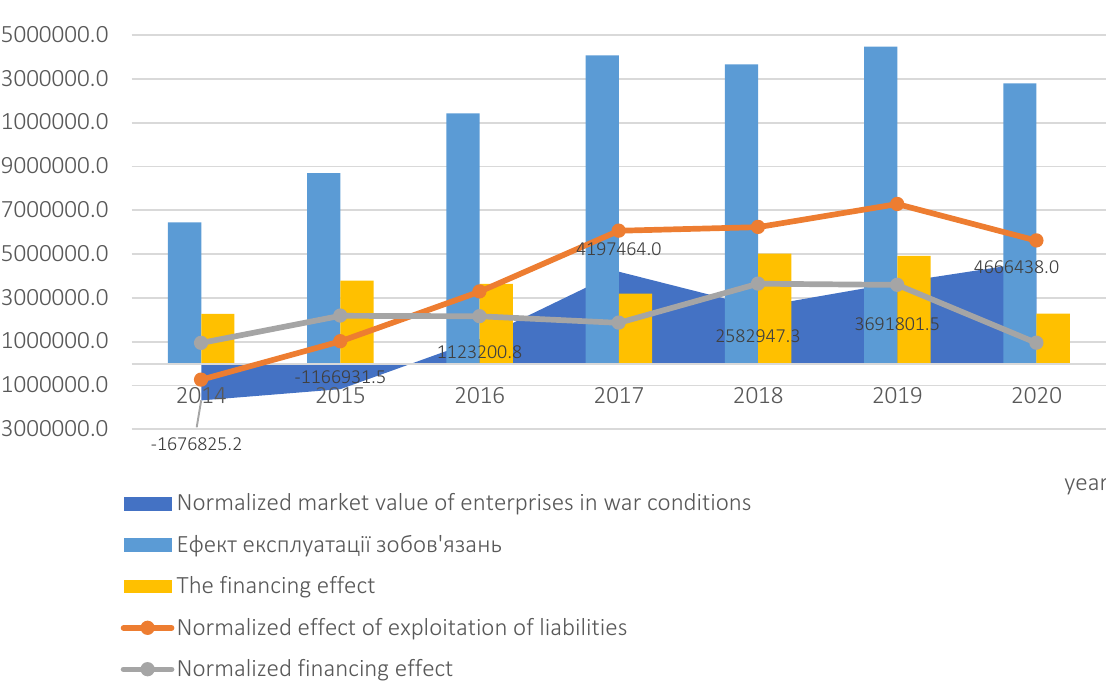
Figure 4. Actual and normalized indicators of the effects of the exploitation of liabilities and financing in the formation of the market value of Ukrainian enterprises in